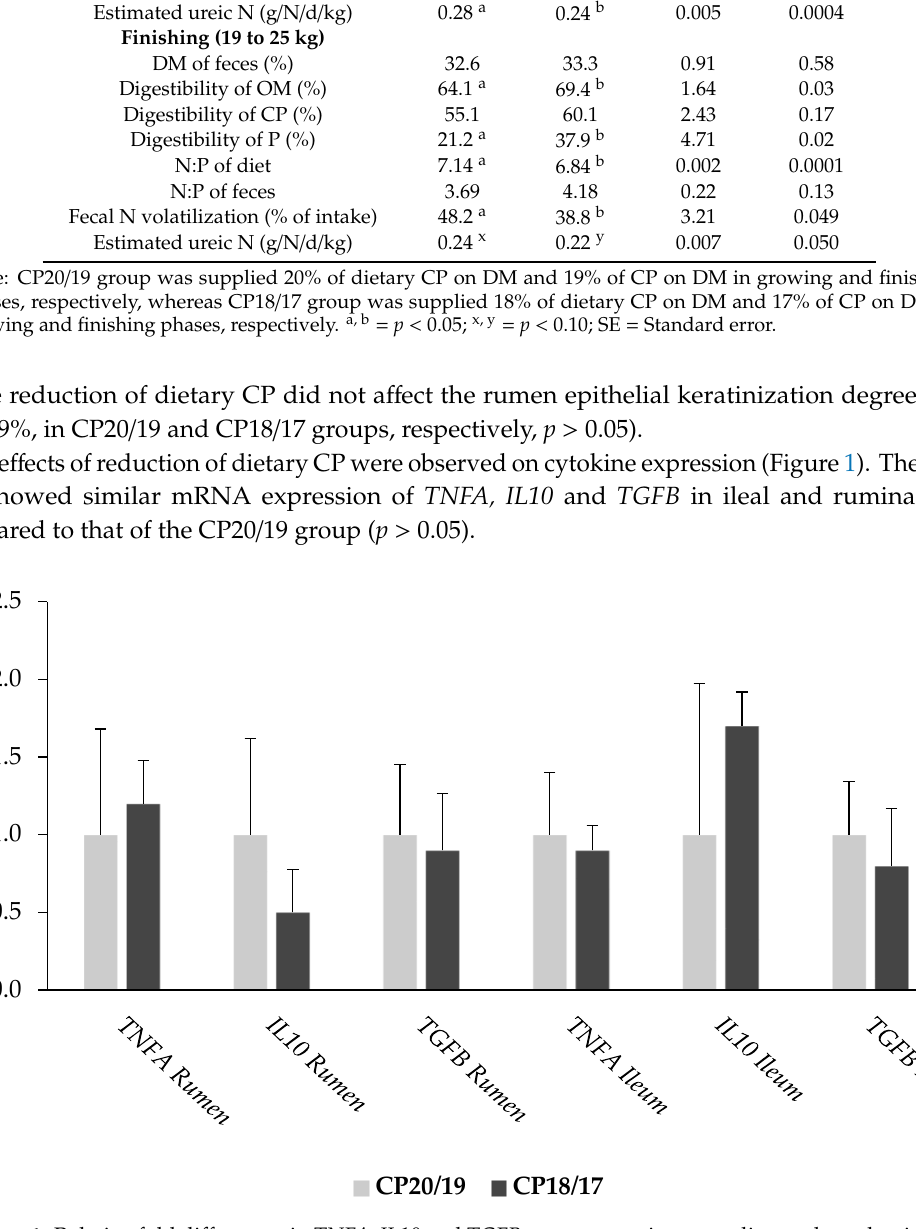
Figure 1. Relative fold differences in TNFA , IL10 and TGFB gene expression according to the reduction of dietary CP. The CP20/19 group was designated as calibrator to compare expression levels. Bars represent least square mean values ± SE (CP20/19 vs. CP18/17; p > 0.05).